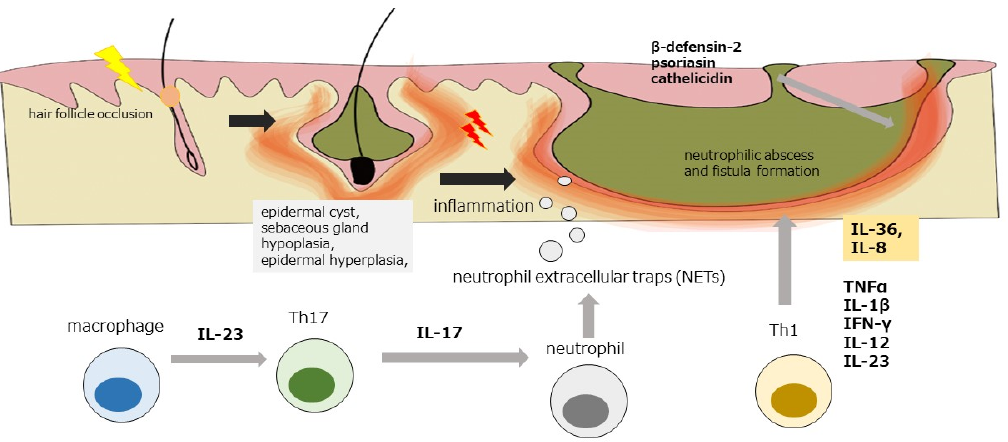
Figure 1. The pathogenesis of HS. The hair follicle occlusion is the initial step for the development of HS; subsequently epidermal cyst, sebaceous gland hypoplasia, epidermal hyperplasia, neutrophilic abscess, and fistula formation may develop, leading to the formation of a subcutaneous complex network in each fistula. TLR2 expression was enhanced in macrophages and dendritic cells, which abundantly express the inflammatory cytokines IL-12 and IL-23. IL-23 is thought to be involved in Th17 cell infiltration in lesions. Other various inflammatory cytokines such as TNF- α , IL-1 β , IFN- γ , IL-12, and IL-36, are expressed in lesions. The production of antimicrobial peptides, such